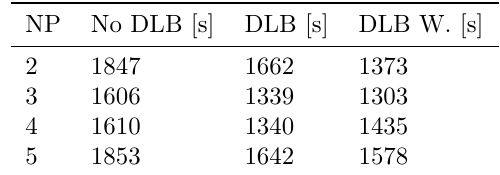
Table 3. Execution times comparing solutions with estimated processing weights (DLB W.), uniform pro- cessing weights (DLB) and without a load balancing (No DLB) framework (Intel i3 - 4 computing units (HT) + Intel i7 - 4 computing